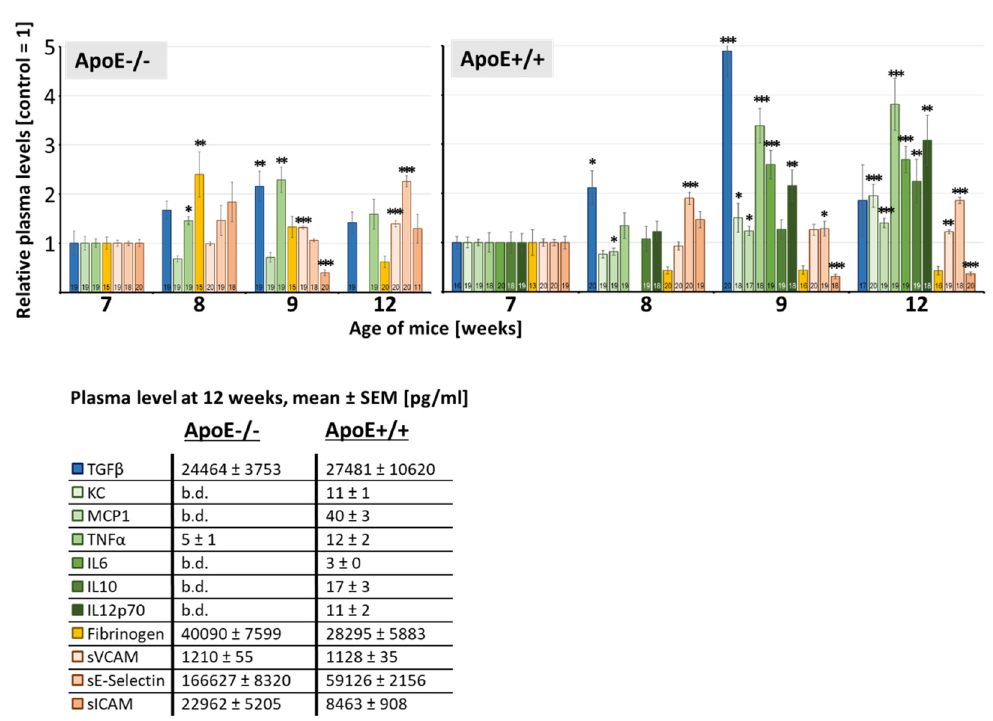
Figure 3. Age-dependent changes of plasma parameters in non-irradiated mice. Relative concentration of 11 plasma markers is presented in 7, 8, 9 and 12-week-old, sham-irradiated 0 Gy control ApoE − / − and ApoE+/+ mice. Significant changes compared to 7-week group (=1) are indicated by asterisks (*, p ≤ 0.05; **, p ≤ 0.01; ***, p ≤ 0.001). Numbers in the bars represent the number of animals (sample size). Absolute plasma values of ApoE − / − and wild type ApoE+/+ mice at 12 weeks of life are given in the table (b.d. = below detection limit).